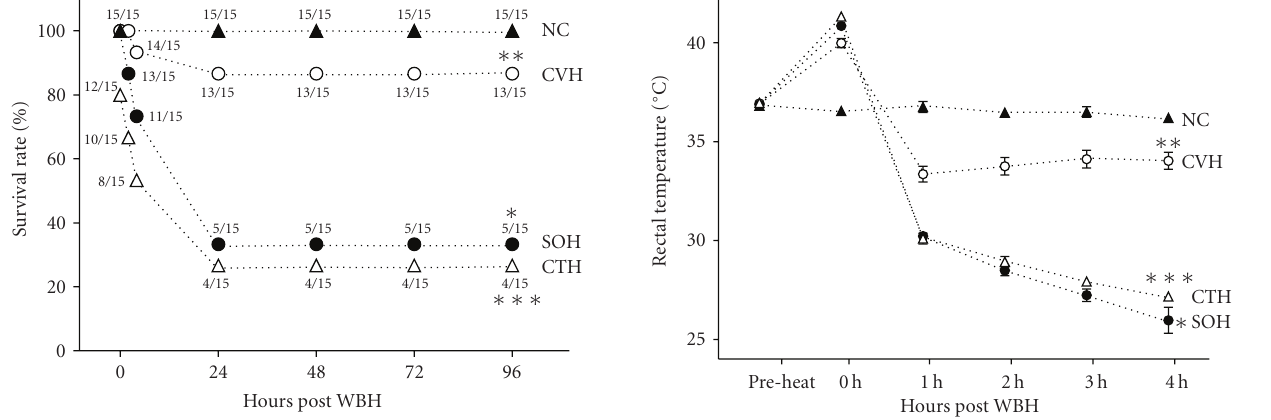
Figure 1: Percentage of survival for normothermic controls (NCs), castrated, vehicle-treated heatstroke (CVH) mice, sham-operated, vehicle-treated heatstroke (SOH) mice, and castrated, testosterone- treated heatstroke (CTH) mice. ∗ P < . 05 compared with NC group. ∗∗ P < . 05 compared with SOH group. ∗∗∗ P < . 05 compared with CVH group.